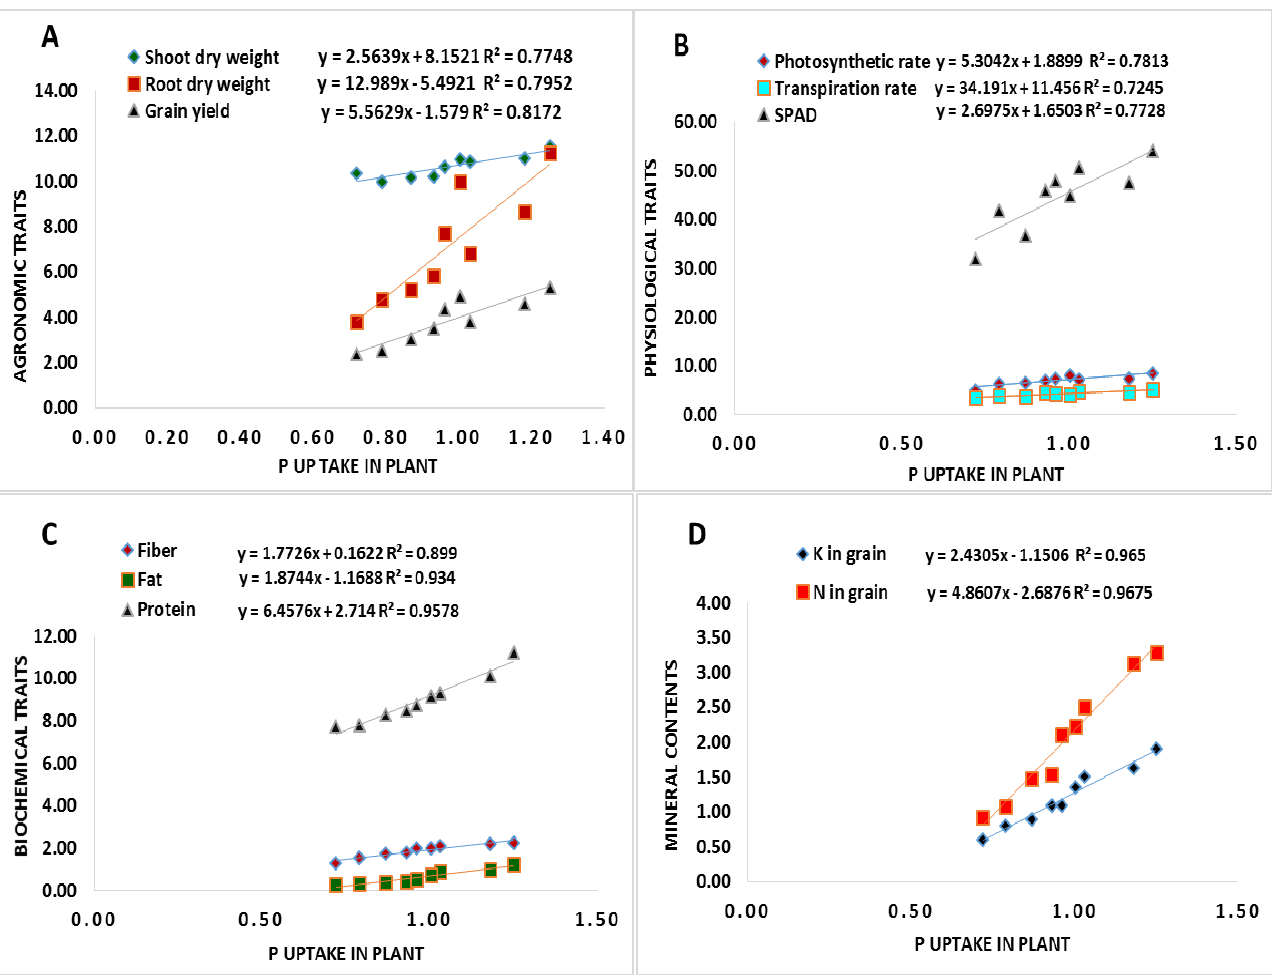
Figure 7. Relationships between plant P uptake and, ( A ) agronomic attributes, ( B ) physiological attributes, ( C ) biochemical attributes, and ( D ) mineral contents of wheat.